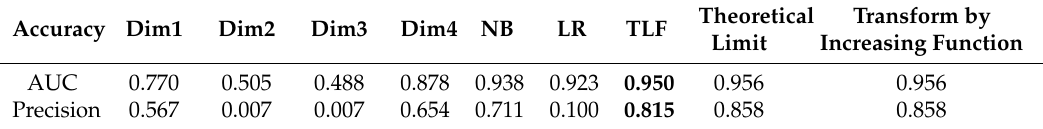
Table 3. Simulation results of group 3. The bold figure indicates the best accuracy in each dimension and combination